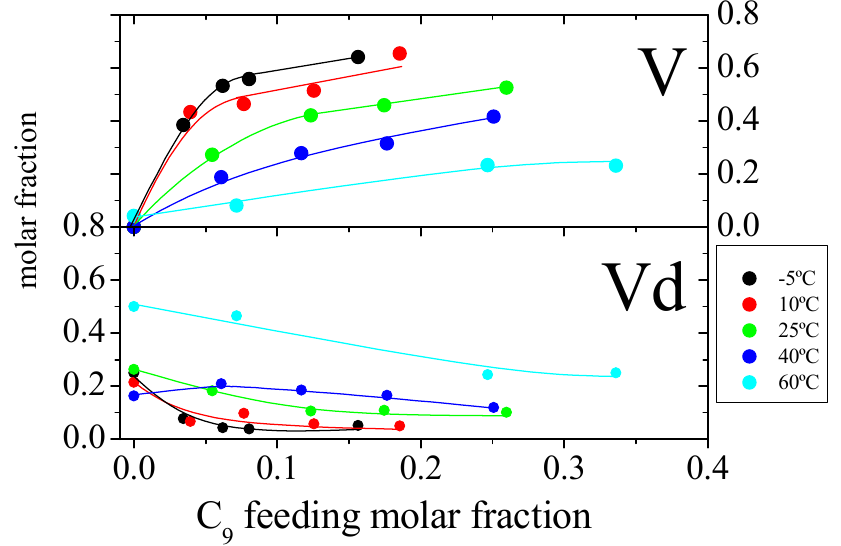
Figure 8. Evolution of Vd and V contents with the C 9 feeding molar fraction for the different series.